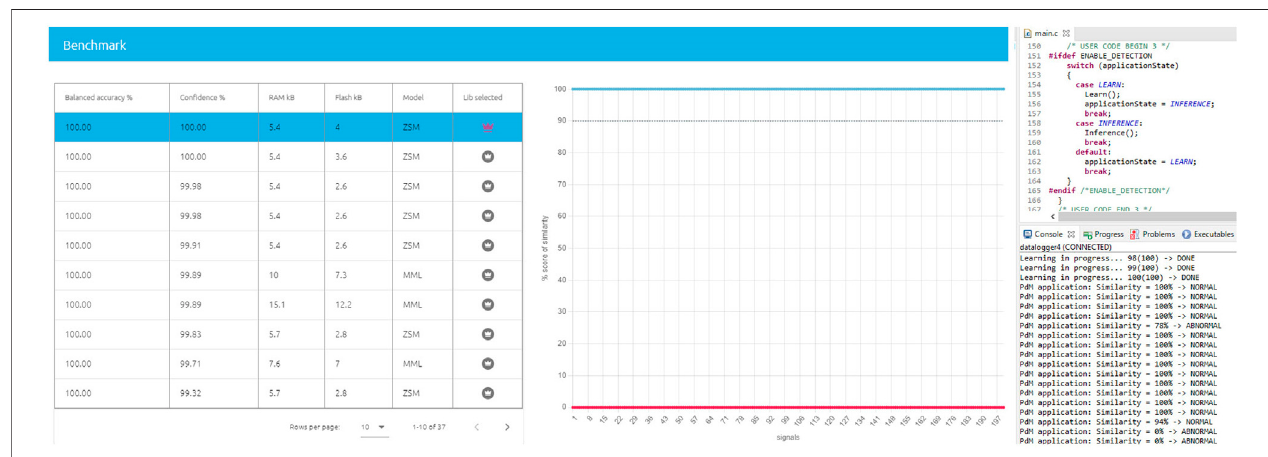
FIGURE 11 | Model benchmarking and snapshot from the inference